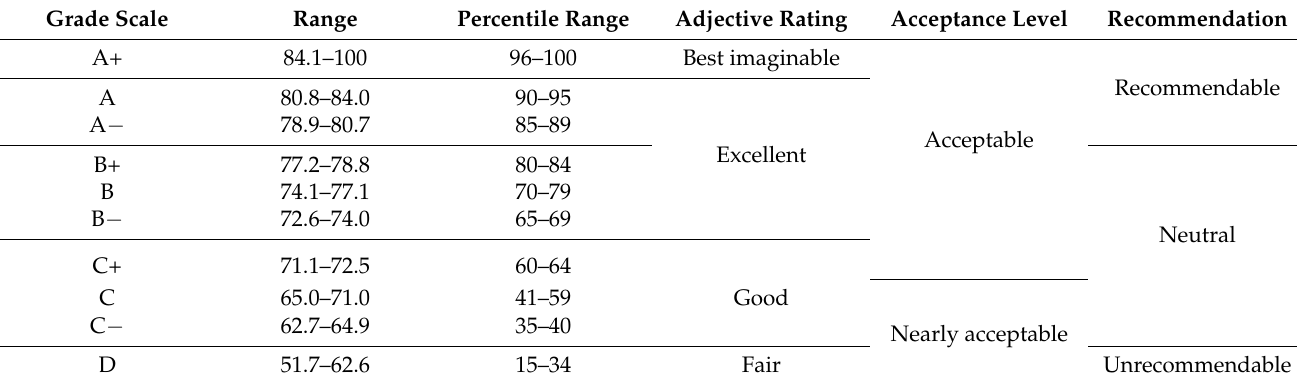
Table 3. SUS score